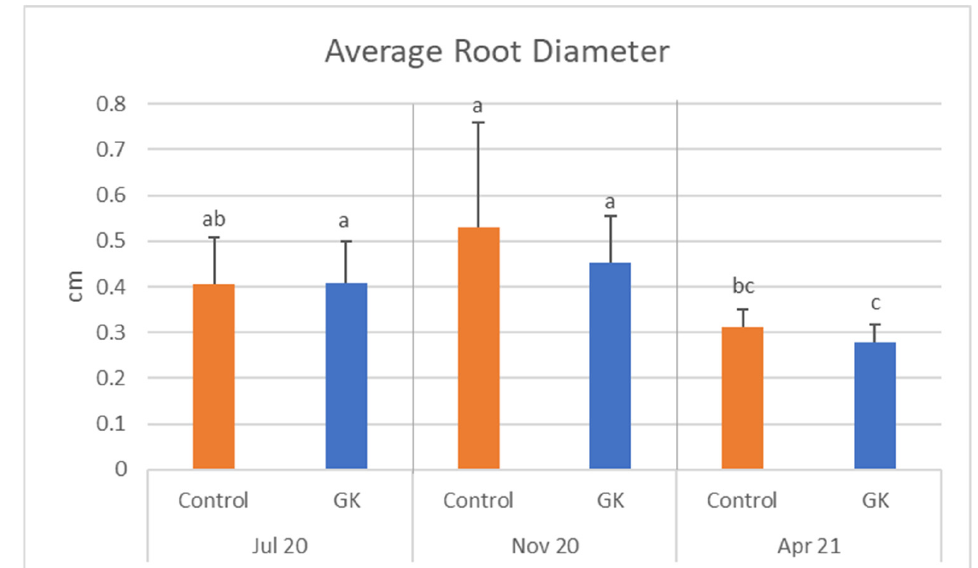
Figure 10. Average root diameter in the three sampling dates. Since no significant differences were found between the Grass Killer (GK) 1.2, 1.7 and 2.6 km per hour working speed treatments, data were analysed together. Control = hoeing machine. Data are means ± standard deviation, different letters indicate significative differences between treatments and sampling dates according to Tukey–Kramer HSD test ( p < 0.05).